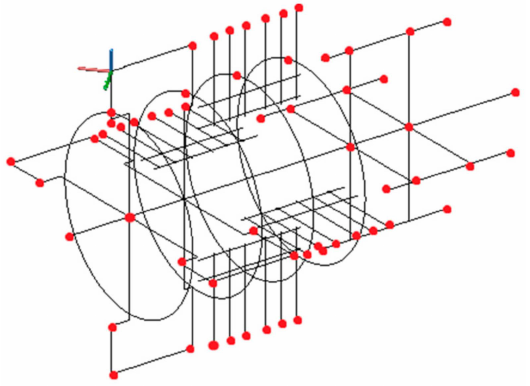
Figure 3. Test point of spindle rotor modal test